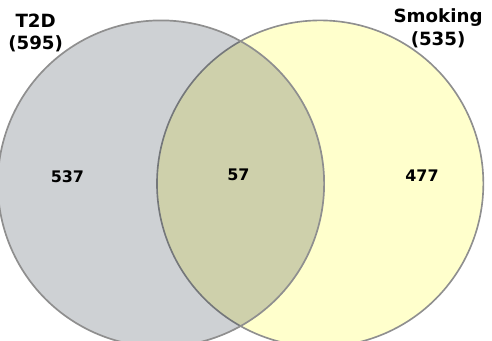
Figure 11. The Venn Diagram represented the shared candidate/biomarker genes found between Type 2 diabetes and smokers from GWAS